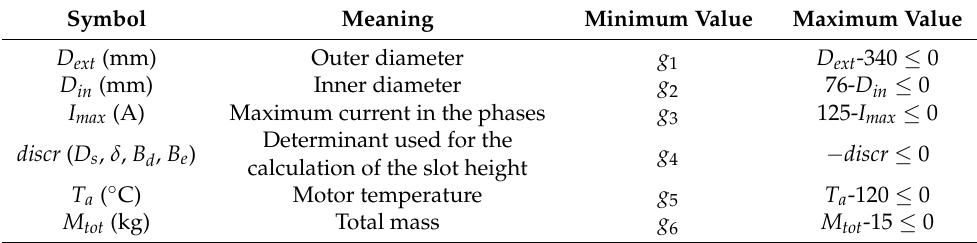
Table 2. Inequality constraints, g i where i = 1, . . . , nc in the brushless DC motor benchmark.